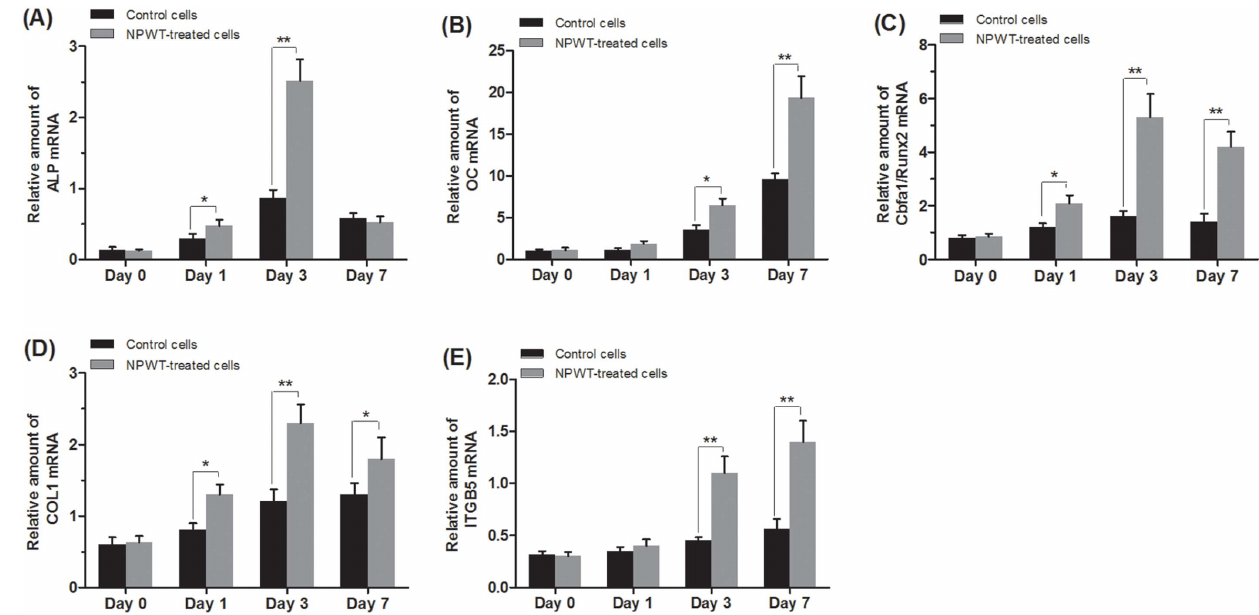
Figure 6. Real-time RT-PCR analysis. NPWT-treated and static control group cell clots were harvested before and 1, 3, and 7 days after incubation (n=3 per timepoint for each group) and analyzed by real-time RT-PCR. The expressions of the specific osteogenic genes (A) ALP, (B) OC, and (D) COL1 were higher in NPWT group than those in control group (* p , 0.05, ** p , 0.01). The NPWT group also expressed higher levels of the osteogenic transcription factor Cbfa1 (also known as Runx2) and the mechanosignaling molecule integrin b 5 (ITGB5) (C) and (E) (* p , 0.05, ** p , 0.01).